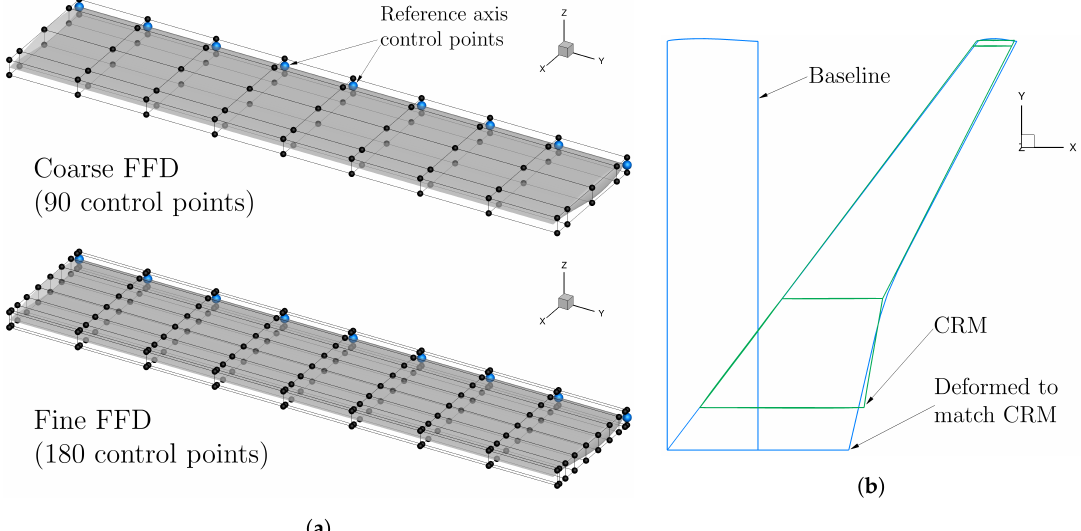
Figure 6. ( a ) Wing surface embedded in the both coarse and fine FFDs. ( b ) The CRM planform is reproduced by modifying the FFD control